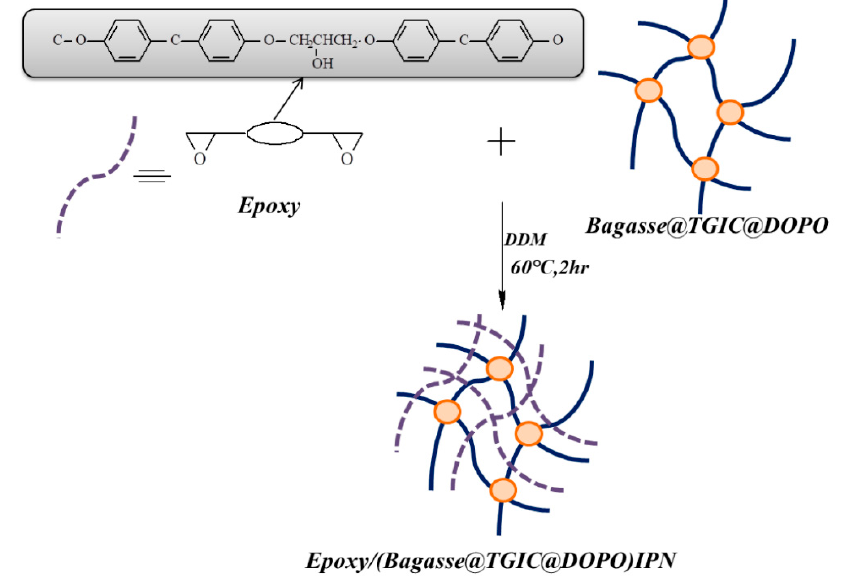
Figure 6. The reaction process of epoxy/bagasse @TGIC@DOPO IPN [50]. Open access. Fiore et al. [51] studied the feasibility of fibers from Arundo Donax, a noon wood plant with very fast growth as a reinforcement for epoxy composites. To make fine fillers, the Arundo Donax plants were collected, dried, and ground by a grinding machine and later sieved by a sieving machine. The fibers were not chemically treated to keep the cost low. The following inference was observed from the study. With the incorporation of fillers, the void content increases, TM increases, and FM marginally changes, while the TS and FS were reduced. The drop in TS and FS was due to (i) the hydrophilic nature of the fillers and (ii) high void content. The dynamic mechanical analysis shows no variations before T g , but after T g , the SM being higher may be due to the presence of rigid filler in the rubbery matrix. Based on the results, the researchers suggested the use of Arundo Donax filler- based epoxy composites for semi-structural applications. Kumar et al. [52] treated bamboo filler with NaOH, and the treated filler was incorporated in the epoxy network to improve the mechanical properties of epoxy composites. The filler content used was 2.5%, 5%, 7.5%, 10%, and 12.5%. The void content in the composites was increased with the increase in the filler content for both untreated and treated filler. However, the treated composites reported minimum void content. The TS and FS were increased with the increase in the filler content (up to 10%) for both untreated and treated filler. Another very interesting example for green epoxy composites was an efficient and eco-friendly solution proposed by Singh et al. [32]. Here, the naturally derived tannic acid is used to modify bamboo micron fibers. The modified fibers are used as a reinforcement to prepare high-performance epoxy composites. The results showed that the incorporation of 5 wt% treated fibers in the epoxy matrix enhanced the stress intensity factor and critical strain energy release rate by ≈ 60% and ≈ 212%,